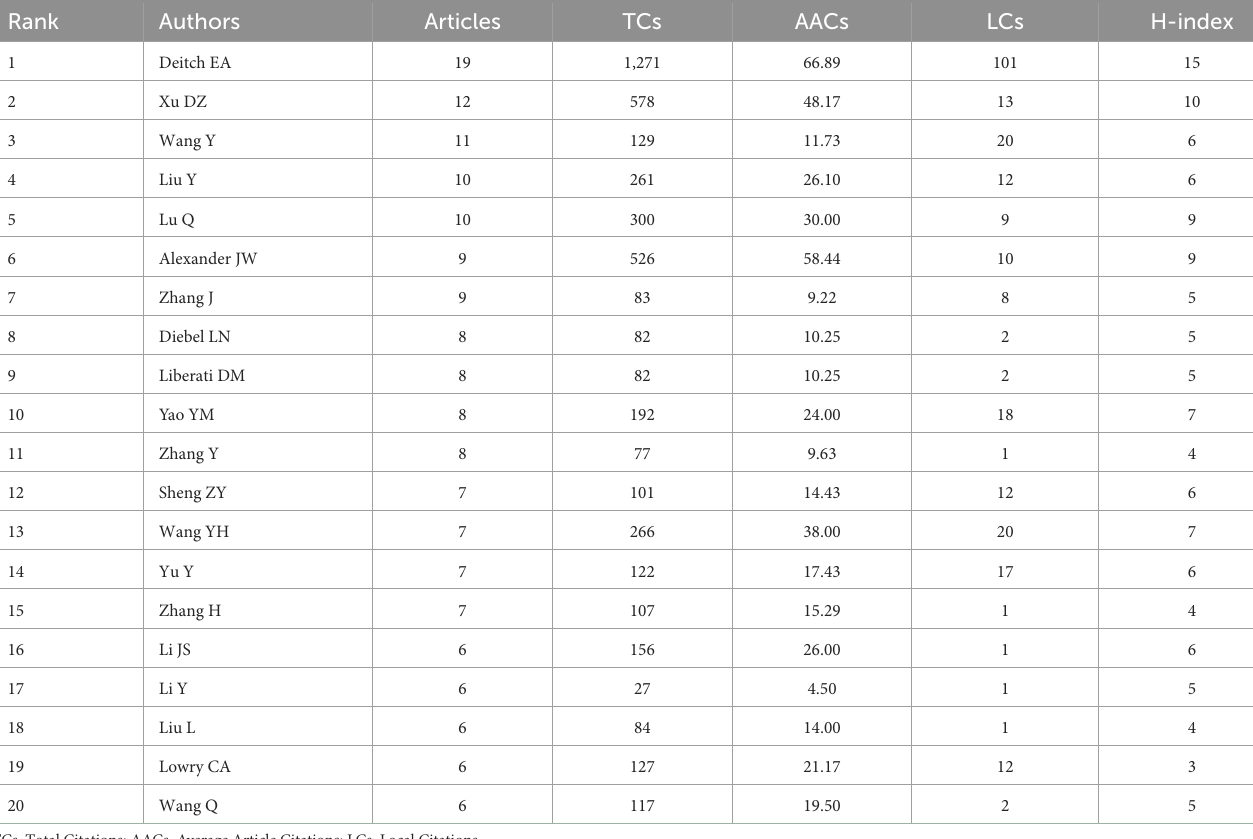
TABLE 3 Top 20 most productive authors for burn and trauma associated with RBPs research.